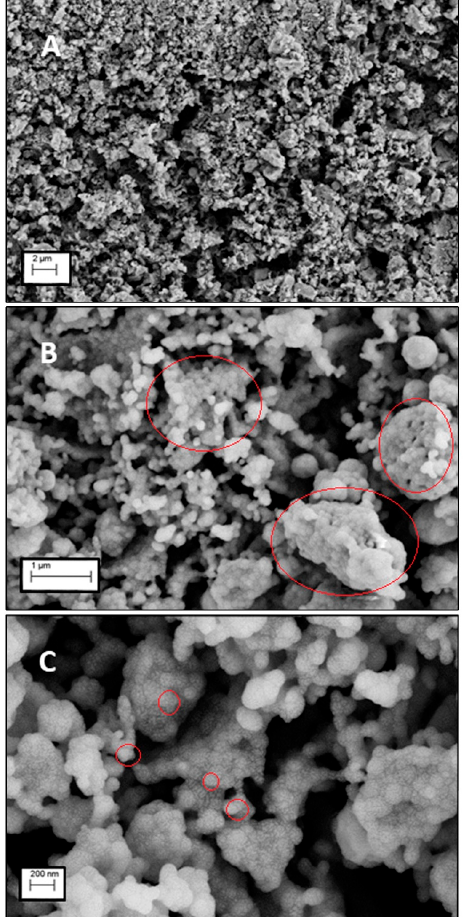
Figure 4. Top view micrographs (fully completed infiltration) of the LSCM / GDCE cathode at increasing magnifications (from A to C). Subfigure A (lowest magnification) gives evidence of the homogeneity of cathode’s porous structure, while the red circles give evidence of the well-dispersed clusters (B) of doped-ceria nanoparticles (C) alongside the whole electrode’s surface.